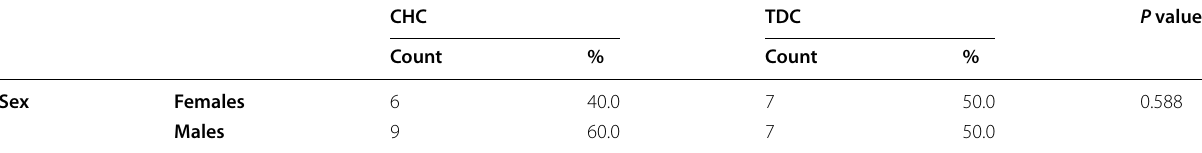
Table 2 Gender distribution of the congenital hypothyroid children (CHC) and typically developing children (TDC)